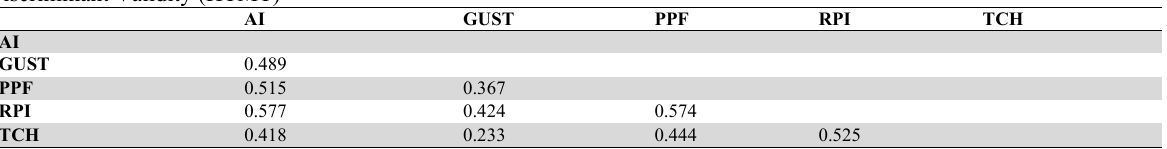
Discriminant Validity (HTMT)